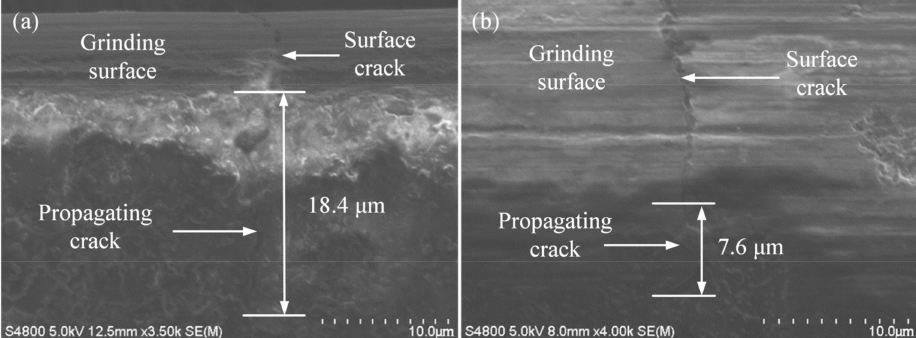
Figure 3. Influence of wheel speed on crack propagation ( a p = 12 µ m, v w = 3500 mm/min): ( a ) v s = 30 m/s; ( b ) v s = 40